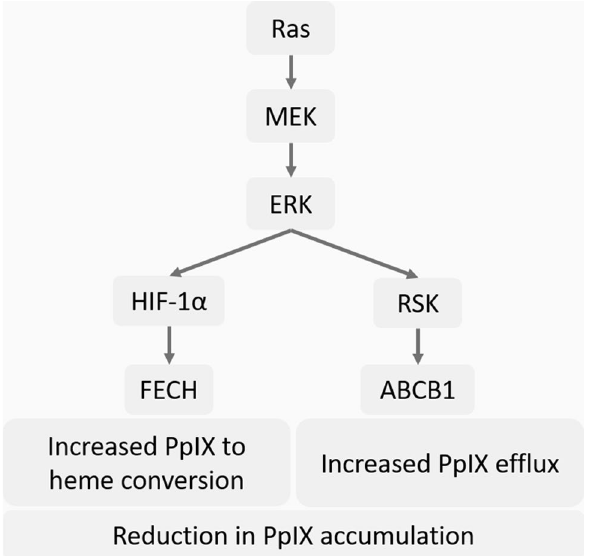
Figure 8. Reduction in PpIX accumulation through the Ras/MEK-HIF-1α-FECH and Ras/MEK-RSK-ABCB1 axes in cancer cells. Ras/MEK activation increases HIF-1α expression, which in turn increases the activity of FECH, the enzyme that catalyses the conversion of PpIX to haem. Ras/MEK activation also upregulates ABCB1 expression through RSKs, which promotes the rate of PpIX